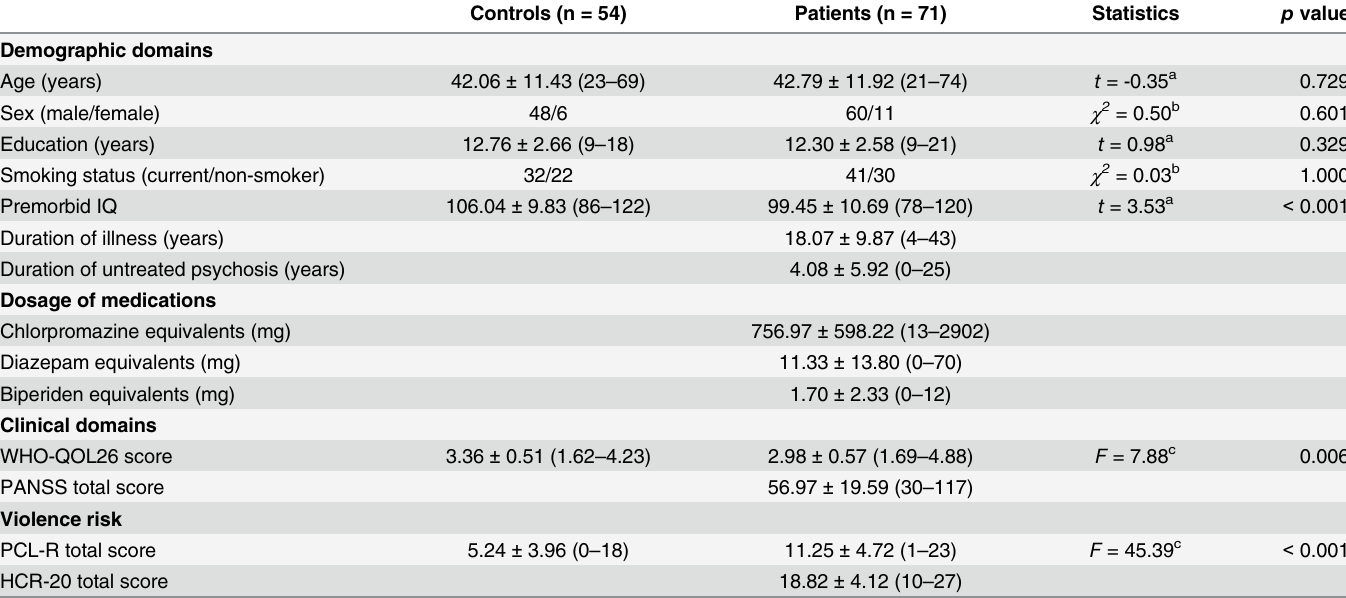
Table 1. Characteristics of demographic and clinical domains and violence risk in forensic patients and healthy